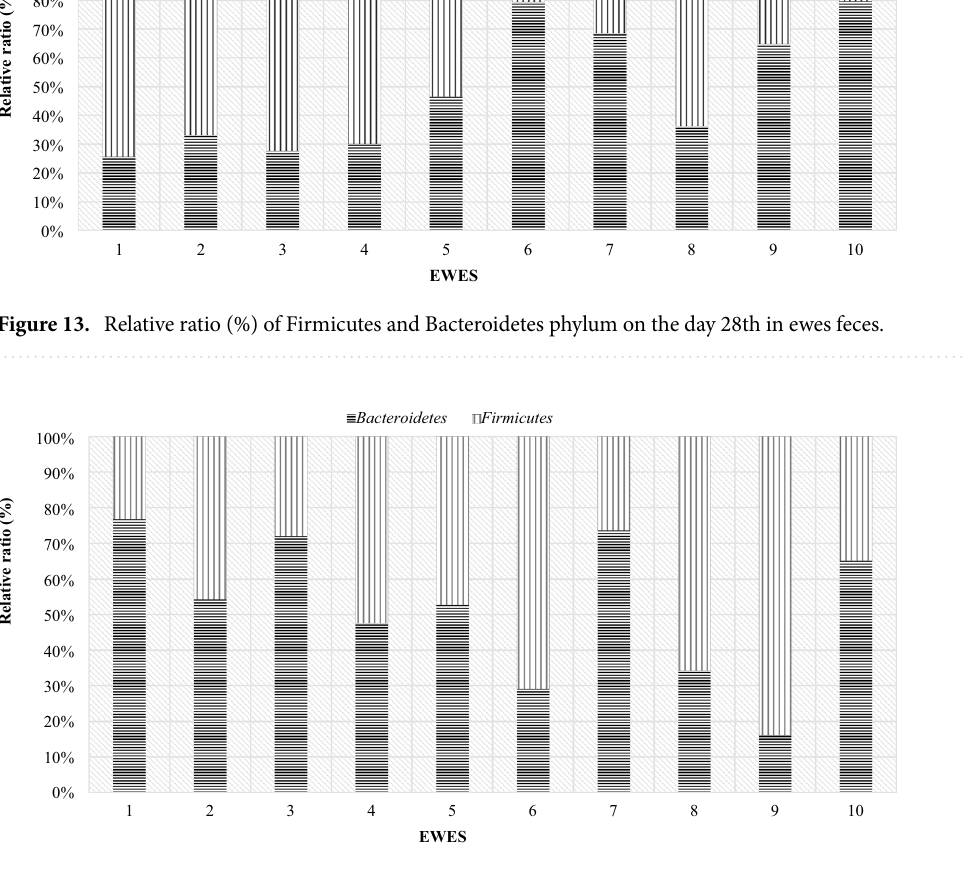
Figure 14. Relative ratio (%) of Firmicutes and Bacteroidetes phylum on the day 56th in ewes feces.